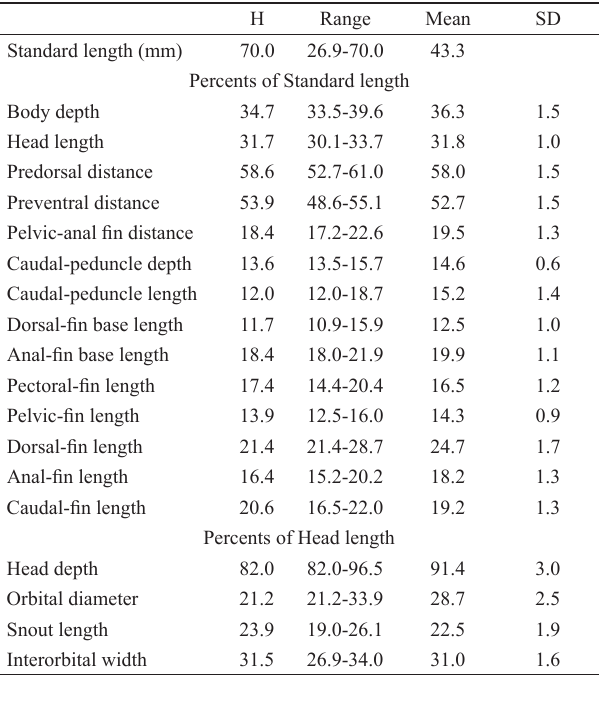
Table 1. Morphometric data for holotype (H) and 32 paratypes of Hasemania uberaba . SD = standard deviation. Range includes